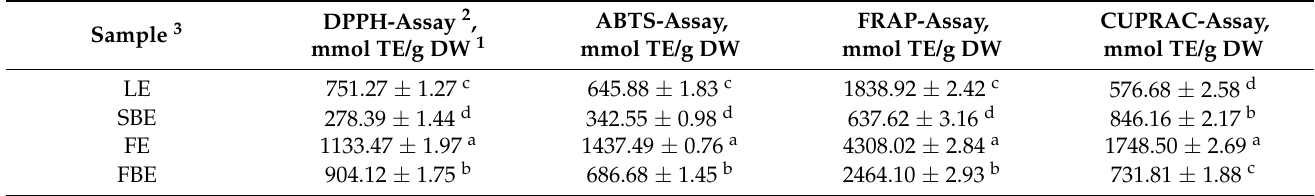
Table 2. In vitro antioxidant activities of extracts from different Koelreuteria paniculata plant